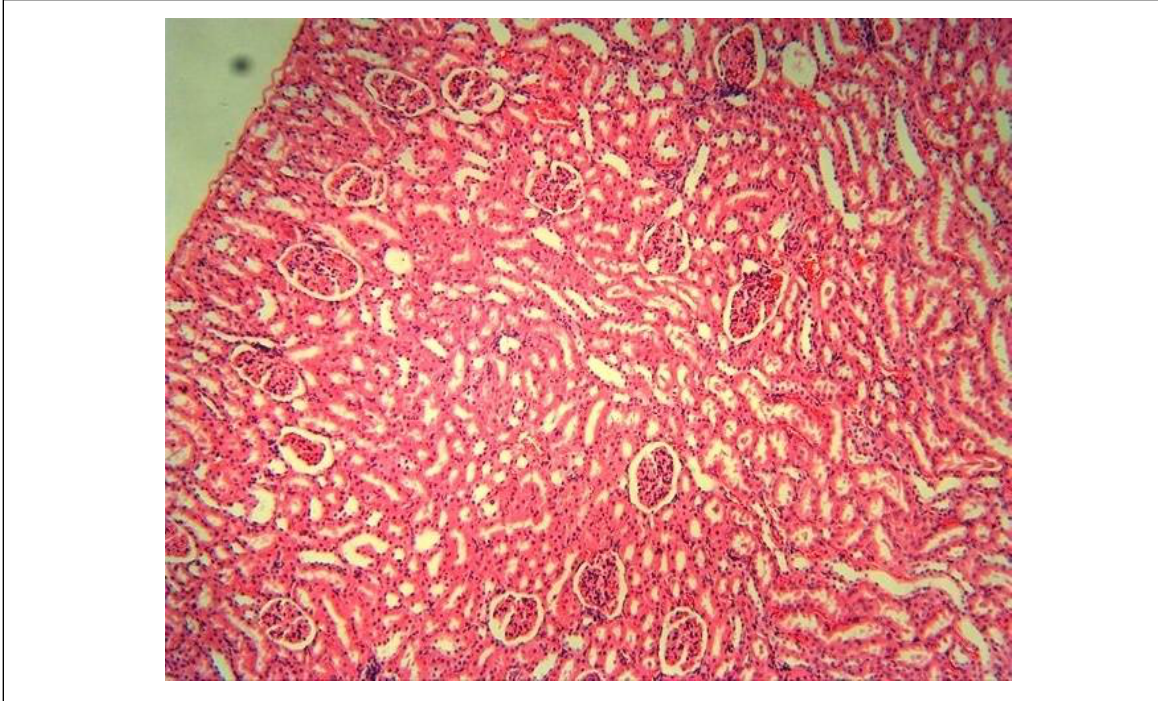
Plate 10: Effect of methanol extract of N. laevis on the kidney of group D (normal control) rats Photomicrographs of the kidney section of group E rats administered with leaf extract of N. laevis 200 mg/ kg alone showed intact glomeruli with kidney architecture, presence of distal and proximal tubules, normal size nuclei, and presence of mild inflammatory cells (Mg.